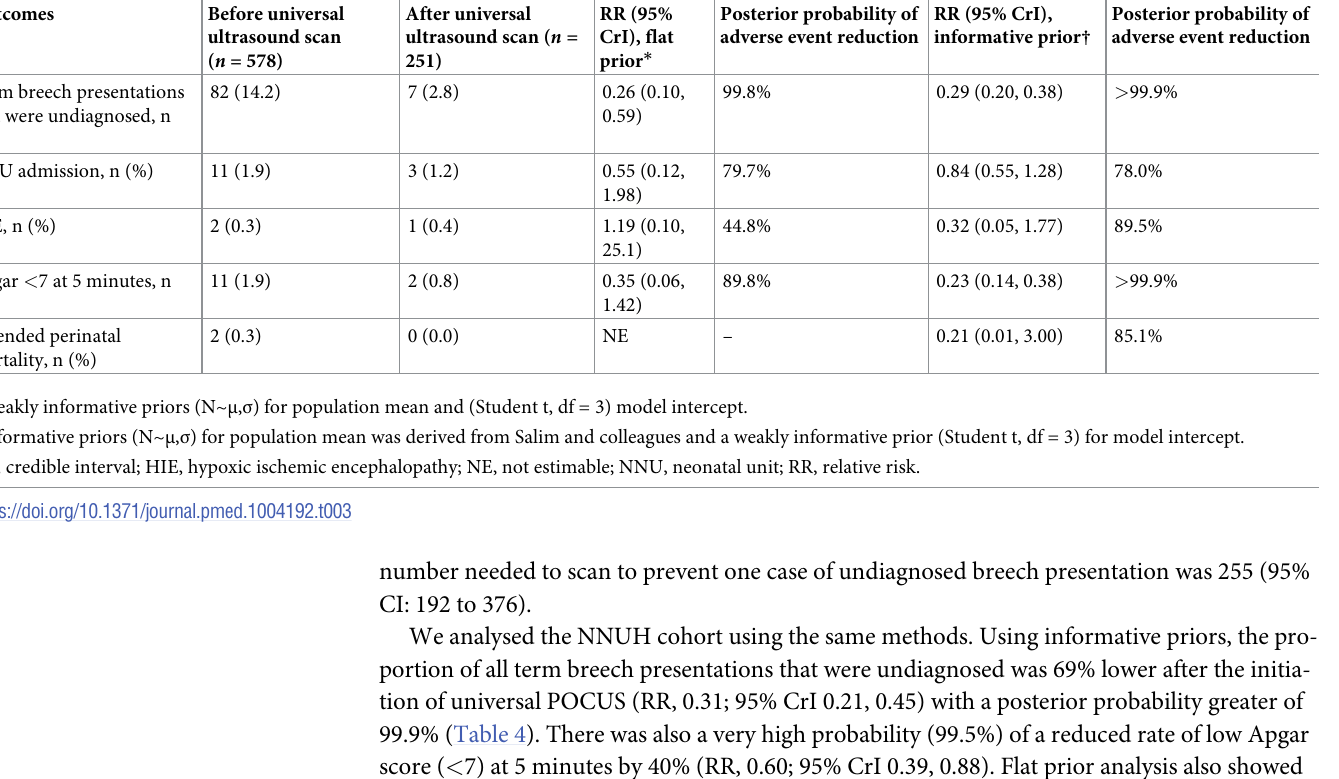
Table 3. Perinatal outcomes of breech presentations in the study epochs before and after the introduction of universal 36-week ultrasound scan in St George’s Hospital. Outcomes